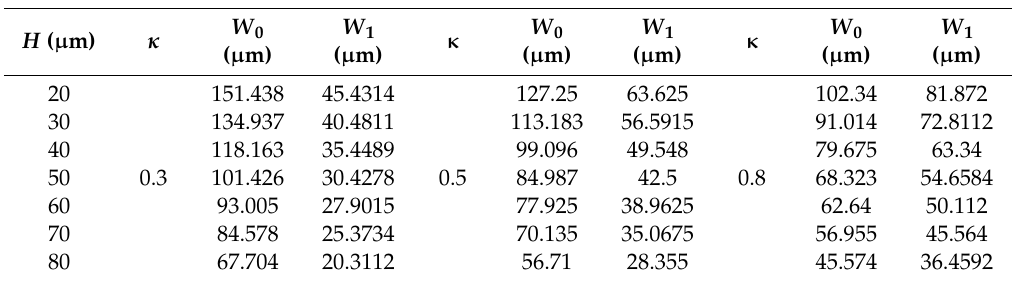
Table 3. Cross-sectional dimensions of the Y-shaped rectangular microchannels with adjusted uniform channel